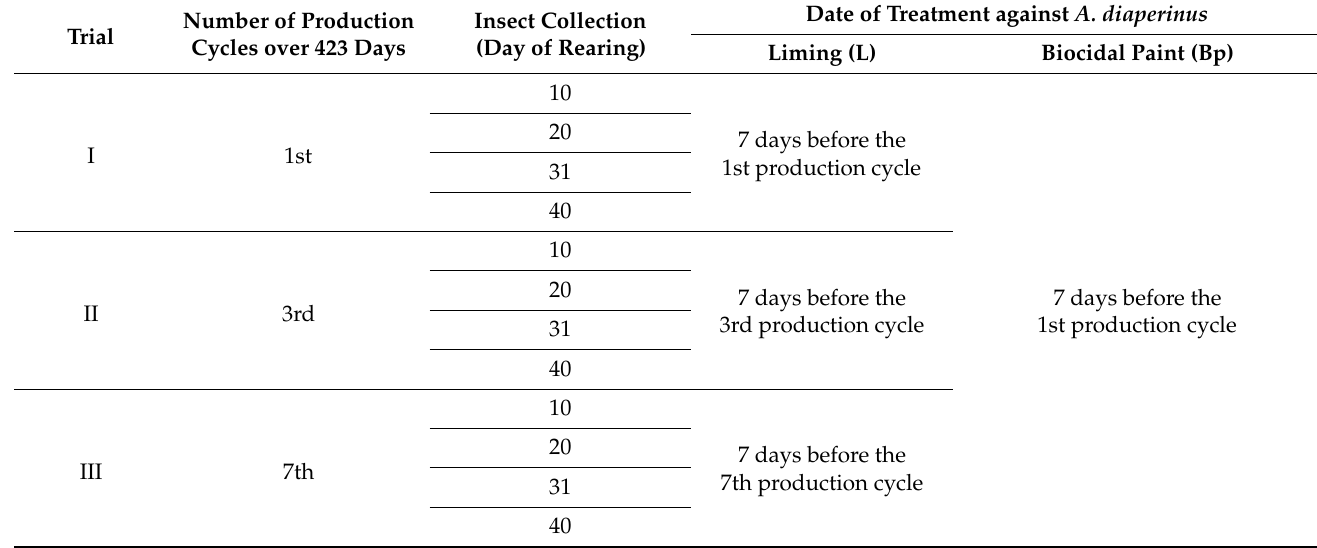
Table 1. Experimental design.